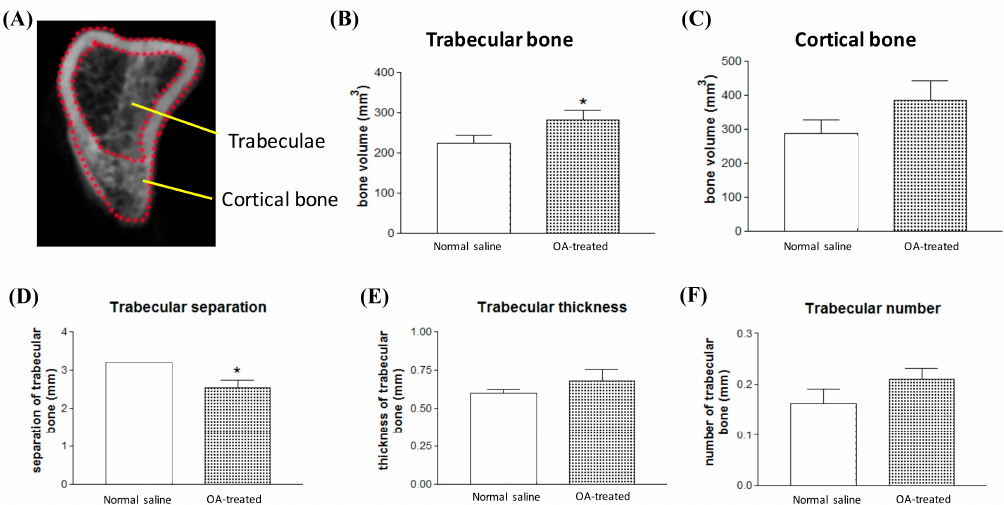
Figure 6. The 3D morphometric parameters show increased trabecular bone volume in OA-treated rat tibias. ( A ) Defined ROI for the trabeculae volume (inside the red dotted line) and cortical (between the red dotted line) bone volume analysis. ( B ) Cortical bone; and ( C ) trabecular bone volume measurement using micro-CT analysis CTAn software. Bone mass index of trabecular bone evaluation including: ( D ) trabecular separation (Tb.Sp).; ( E ) trabecular thickness (Tb.Th).; and ( F ) trabecular number (Tb.N). * p < 0.05.